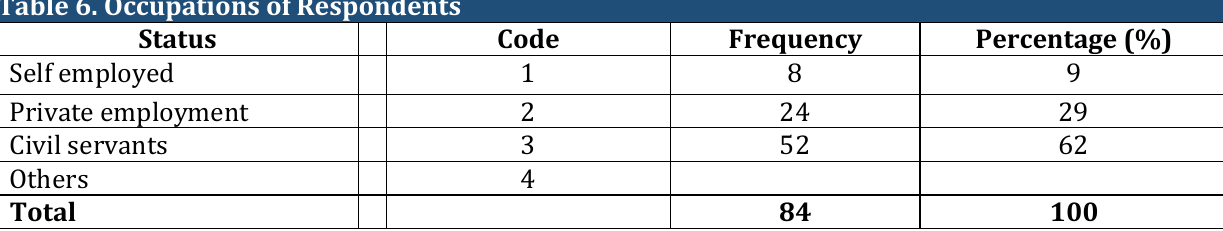
Table 6. Occupations of Respondents